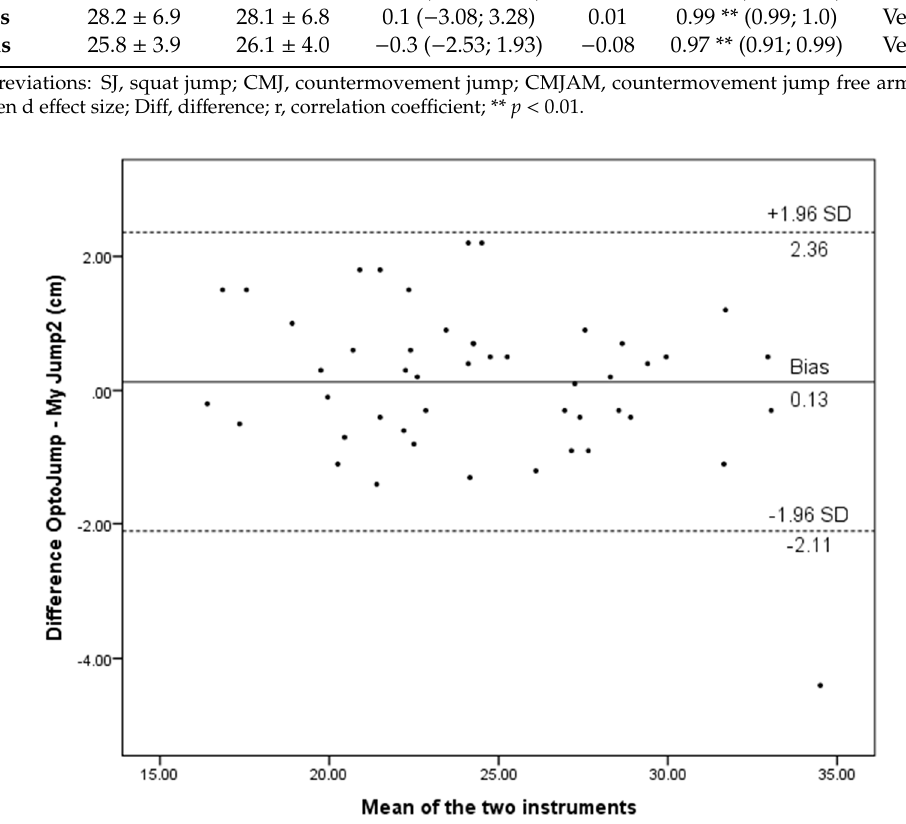
Figure 2. Level of agreement (Bland–Altman) with 95% limits of agreement (dashed lines) and the mean difference (solid line) between My Jump 2 and the OptoJump for SJ in the whole sample. plot depicting limits of agreement for CMJ between the OptoJump and My Jump 2 show that the for CMJ was 0.13